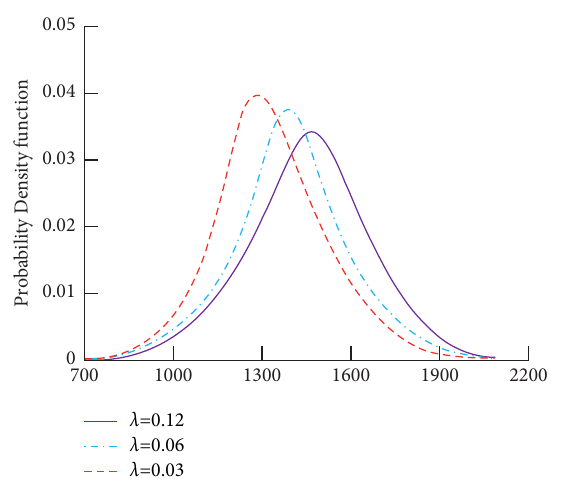
Figure 2: Probability density curve of service response